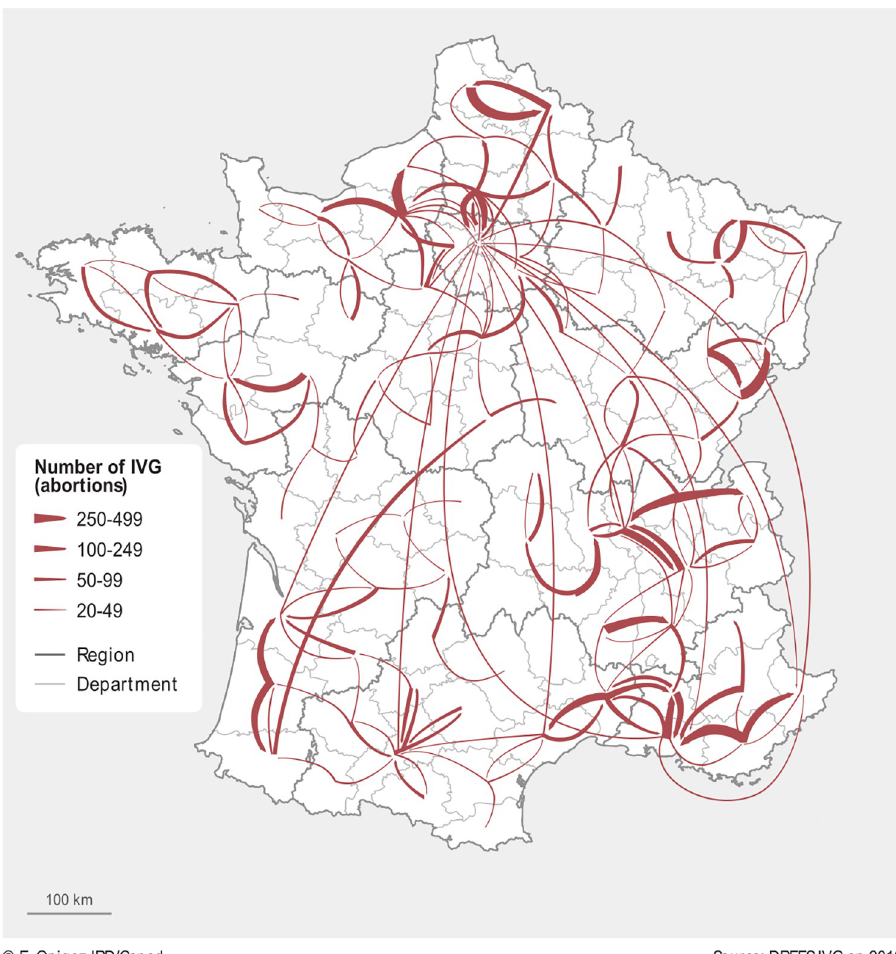
Fig 2. Inter-departmental abortion travels, metropolitan France, 2019. Source: [11]. Map produced by